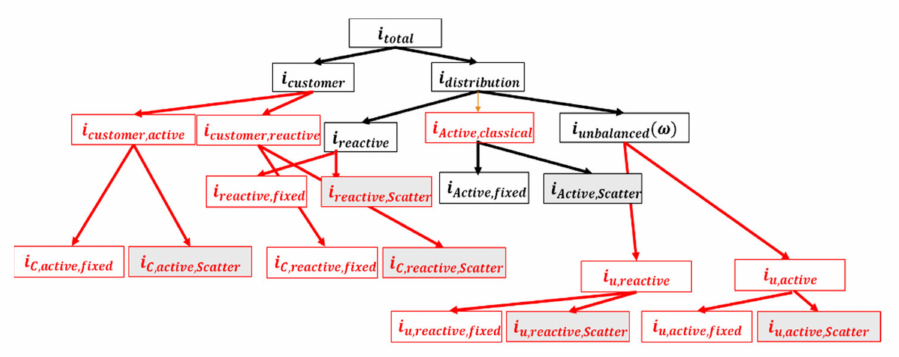
Figure 4. Further disassembly of CPC in favor of the grid/machinery disassembly method. Scattering currents are marked with a gray background, new currents are in red